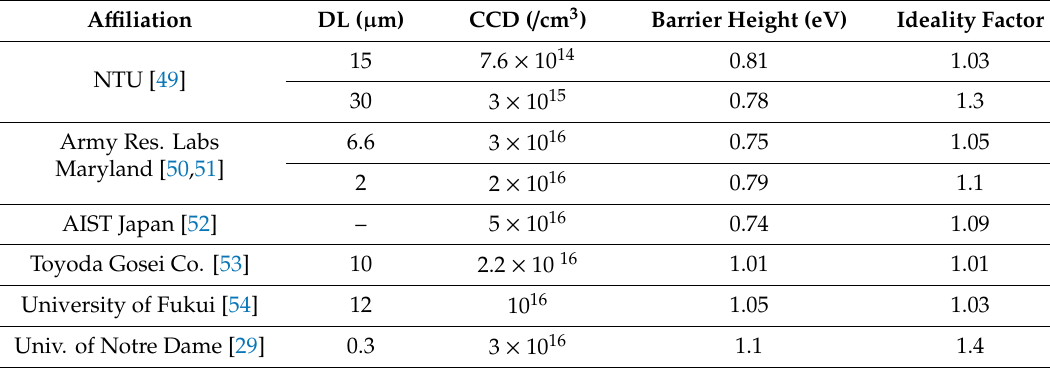
Table 5. List of state-of-the-art SBDs fabricated on GaN-on-GaN